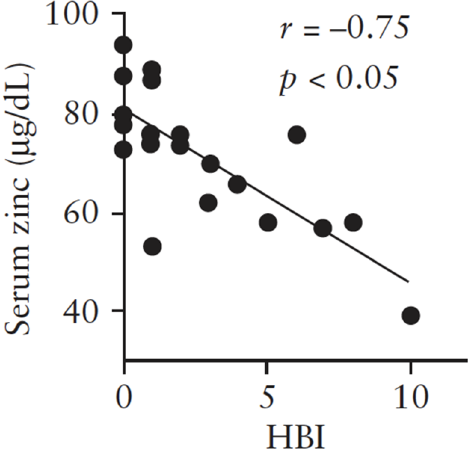
Figure 3. The association between serum zinc levels and clinical activity in patients with Crohn’s disease. HBI, Harvey–Bradshaw Index, an index of clinical activity for Crohn’s disease ( n = 22). Cited from Higashimura et al. [44]. (used with permission)